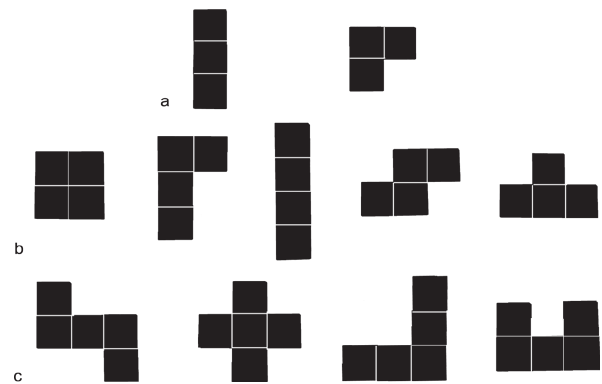
Figure 7. Basic shapes used to measure the similarity score between the digitalized cell distance matrix heat maps and the sona patterns. Each shape present in both of the compared patterns added the number of points equivalent to the number of blocks comprising it to the similarity score: 3 points (a), 4 points (b) or 5 points (c). Each shape that was not a part of a larger shape, but was distinct in both patterns added the squared number of blocks comprising it to the similarity score: 3 2 points (a), 4 2 points (b) or 5 2 points (c). Overall, the number of identical shapes in subfi gures (a), (b) and (c) was used to derive the numbers k/k’, l/l’ and m/m’, respectively, and compute the similarity score, S.